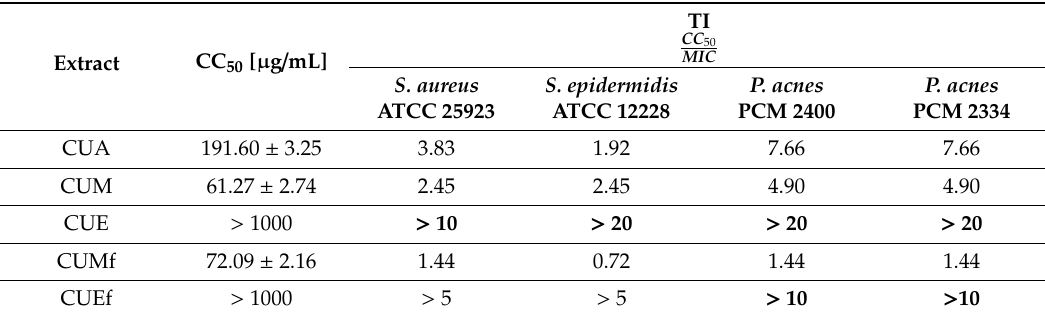
Figure 3. Viability of normal human skin fibroblasts (BJ cell line, ATTC CRL-2522 ™ ) after 24 h incubation with the most active extracts (CUA, CUM, CUE, CUMf, CUEf). * Significantly di ff erent results compared to control (culture medium without extracts—0 µ g / mL); unpaired t -test, p < 0.05. Table 7. The half-maximal cytotoxic concentrations (CC 50 ) and therapeutic indexes (TI) of the most active extracts (CUA, CUM, CUE, CUMf,